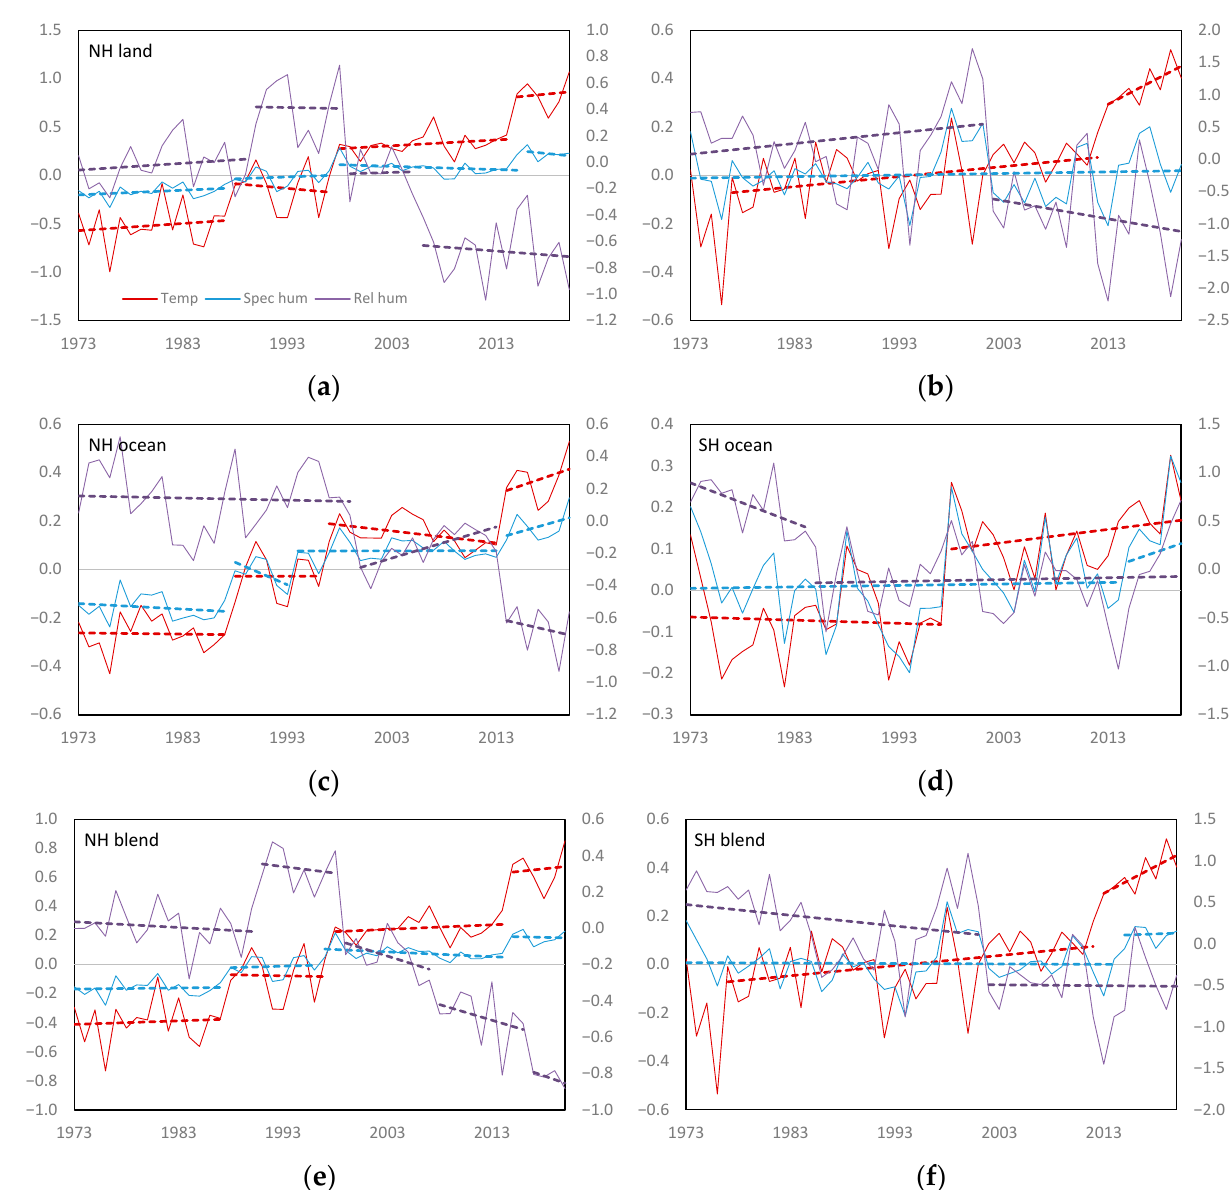
( f ) Figure 1. Annual anomalies (1981–2010) and regimes showing internal trends (dashed lines) for global and tropical average temperature (T), specific humidity (q) and relative humidity (RH) for ( a ) global land, ( b ) tropical land, ( c ) global ocean, ( d ) global ocean, ( e ) global blend and ( f ) tropical blend (Willett et al. 2020). Units are °C for temperature and g kg − 1 for specific humidity on the left axis and % for relative humidity on the right axis. Solid lines are annual values and dashed lines